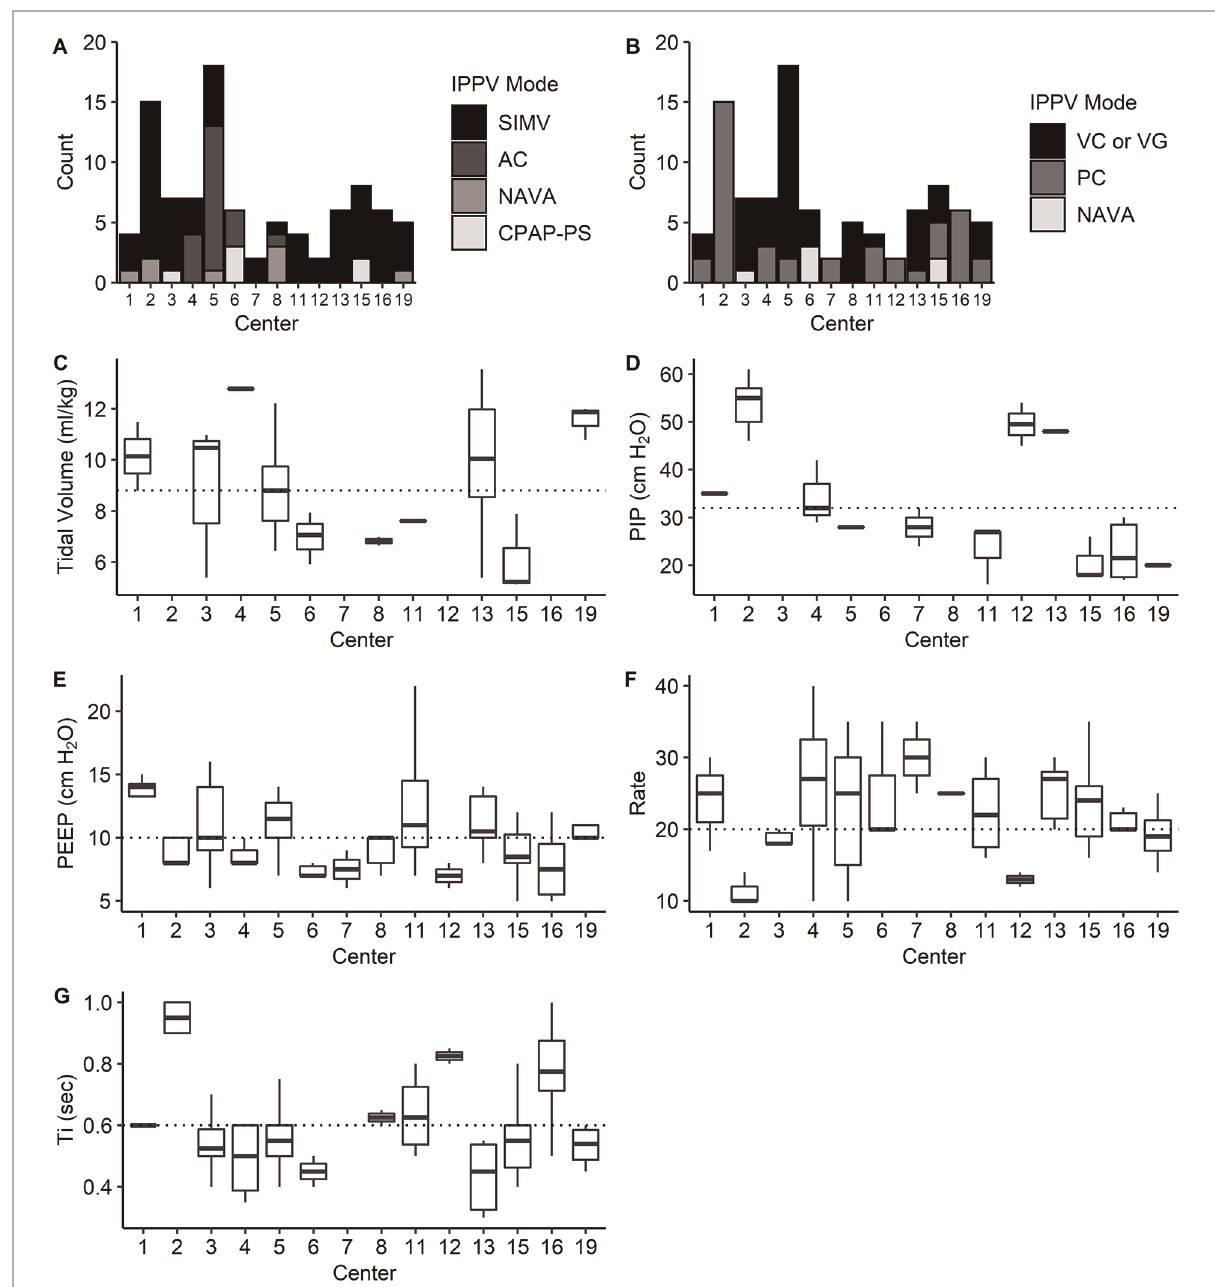
FIGURE 1 The distribution of IPPV modes and settings strati fi ed by center. ( A ) Mode selection varied signi fi cantly by center when comparing the use of AC, SIMV, NAVA, and CPAP-PS ( P <0.0001, χ 2 test). ( B ) Mode selection varied by center when comparing VC/VG, PC, and NAVA modes ( P